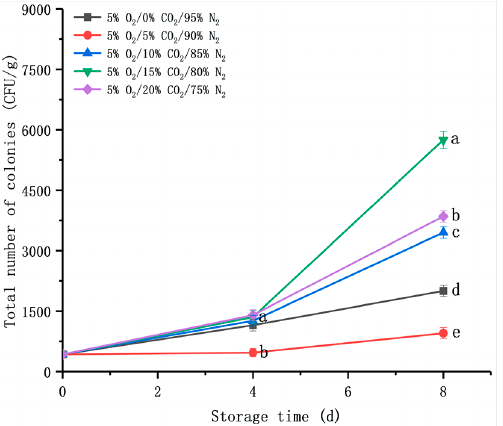
Figure 8. Effect of CO 2 concentration (%) with 5% O 2 on total colony numbers of fresh-cut Dicty- ophora rubrovolvata . Differences at p < 0.05 are indicated by different letters and data are expressed as the mean ± SD.